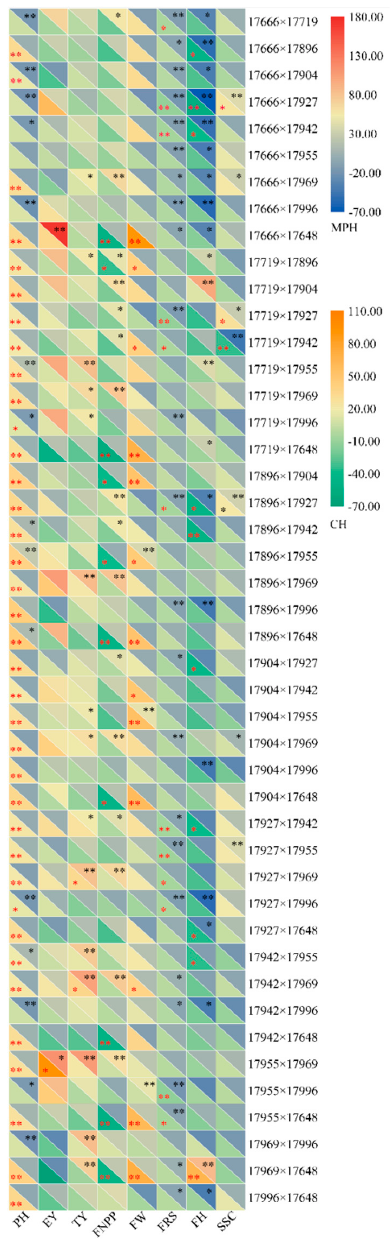
Figure 4. Evaluation of heterosis for eight main agronomic traits. The vertical axis represents the different combinations, and the horizontal axis represents the different traits. The degree of heterosis is coded according to the color key plotted on the right. In the boxes, the top right triangle indicates the level of midparent heterosis (MPH); the LSD0.05 and LSD0.01 values of each trait from left to right were 11.21 and 14.85, 110.01 and 145.72, 51.97 and 68.85, 44.57 and 59.04, 29.20 and 38.67, 4.39 and 5.81, 31.01 and 41.07, 25.31 and 33.53. The bottom left triangle indicates the level of comparison heterosis (CH); the LSD 0.05 and LSD 0.01 values of each trait from left to right were 12.31 and 16.31, 98.48 and 130.44, 32.36 and 42.86, 33.38 and 44.21, 37.19 and 49.26, 3.86 and 5.12, 34.19 and 45.29, 22.30 and 29.55. The symbols * and ** indicate significance at 0.05 and 0.01 probabilities, respectively.